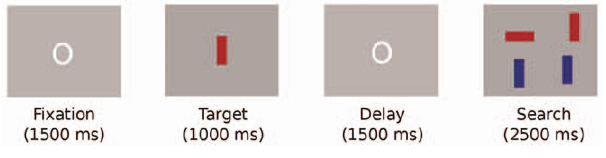
Figure 2. Example trial. Each trial consists of fixation (1500 ms), target (1000 ms), delay (1000 ms), and search display (2500 ms)